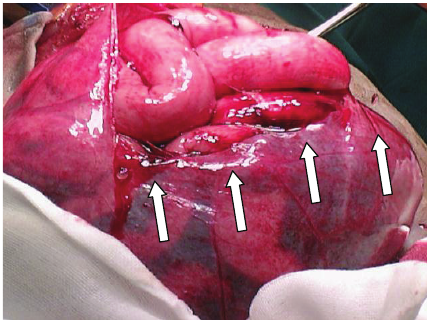
Figure 2: Multiple small bowel perforations (indicated by arrows).